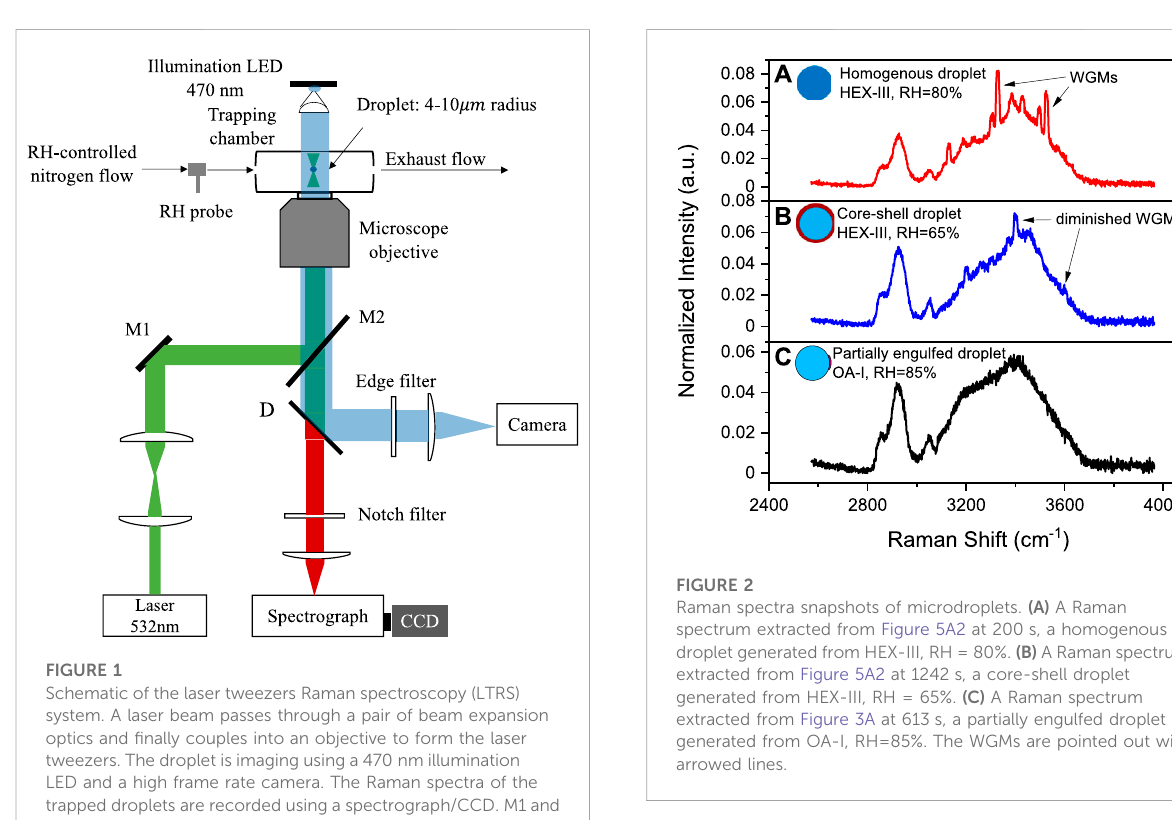
FIGURE 2 Raman spectra snapshots of microdroplets. (A) A Raman spectrum extracted from Figure 5A2 at 200 s, a homogenous droplet generated from HEX-III, RH = 80%. (B) A Raman spectrum extracted from Figure 5A2 at 1242 s, a core-shell droplet generated from HEX-III, RH = 65%. (C) A Raman spectrum extracted from Figure 3A at 613 s, a partially engulfed droplet generated from OA-I, RH=85%. The WGMs are pointed out with arrowed